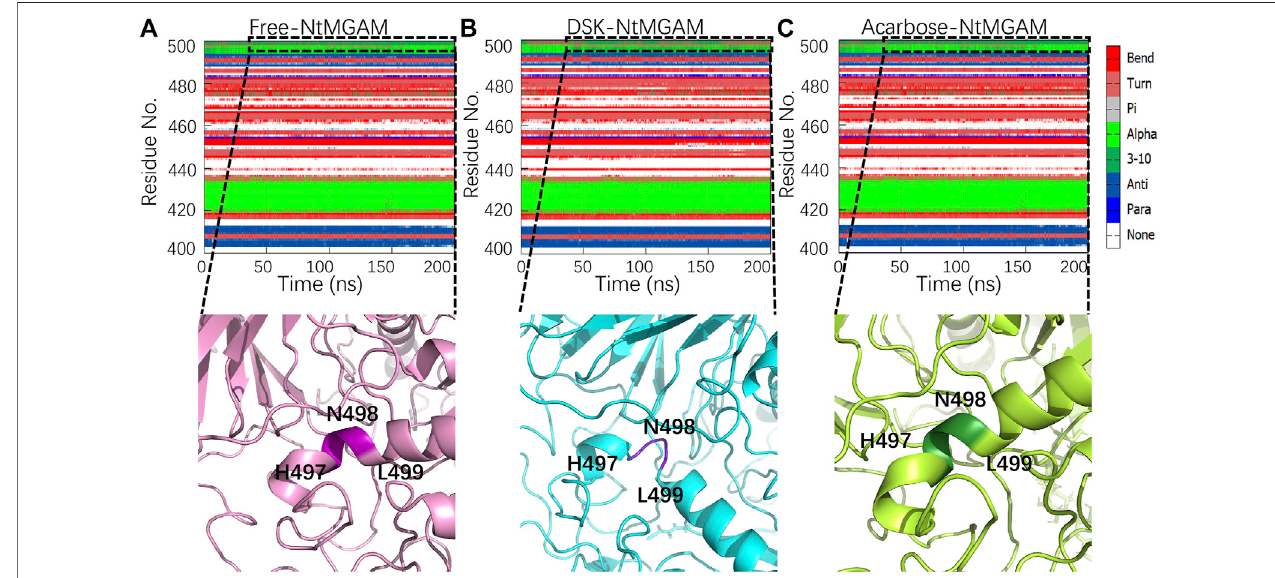
FIGURE 6 | Conformation changes in residues Asn491-Leu493 of the three systems: (A) free-NtMGAM, (B) DSK-NtMGAM, and (C) acarbose-NtMGAM.